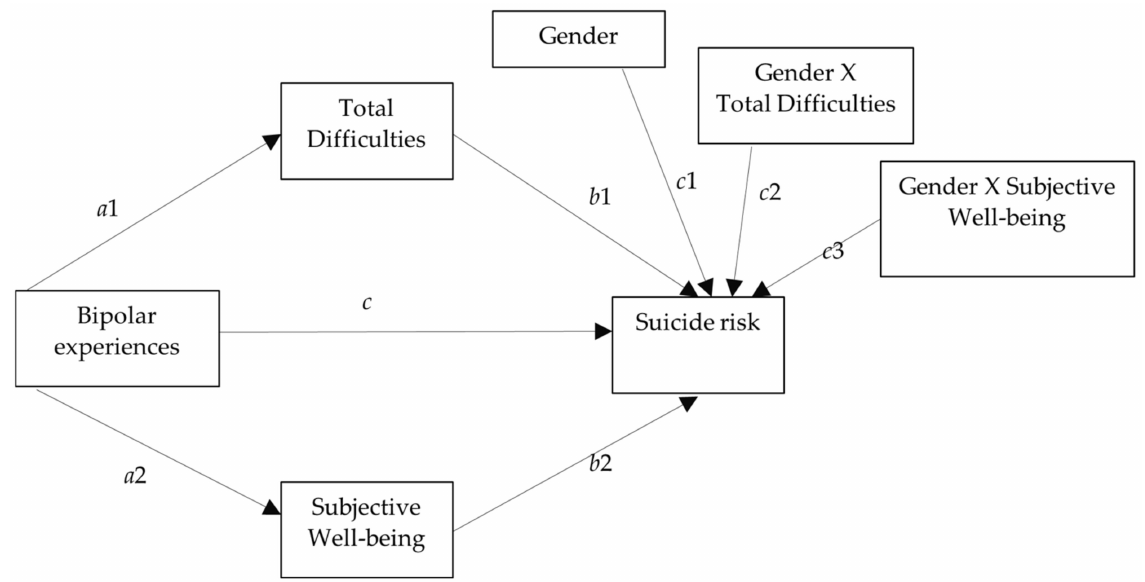
Figure 1. Statistical mediation model moderated by gender. The lettering describes the paths. The R program [79,80] was used, through ULLRToolbox